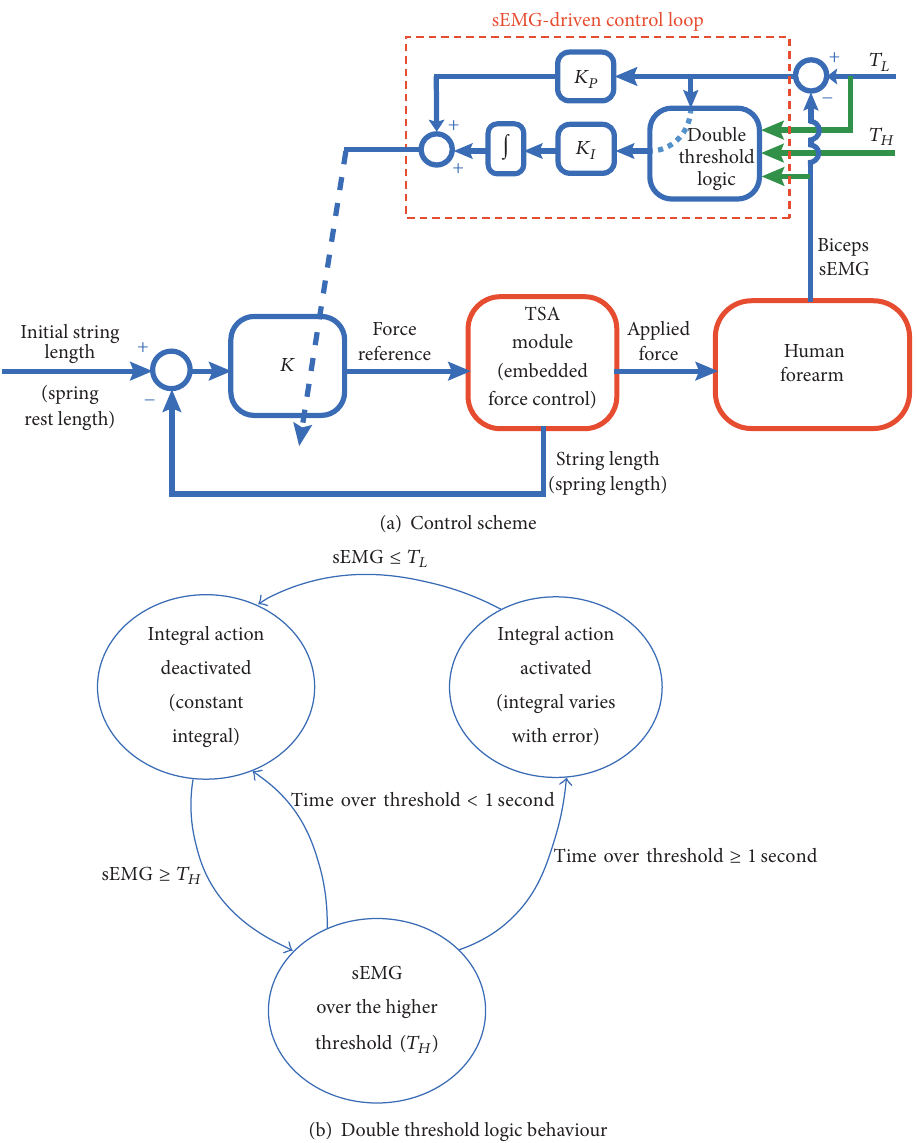
Figure 12: Variable stiffness control scheme of the TSA module for the assistive